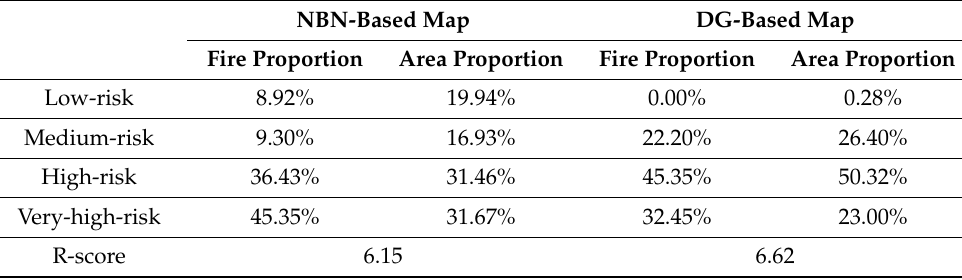
Table 7. Comparison of NBN-based map and DG-based map NBN-Based Map